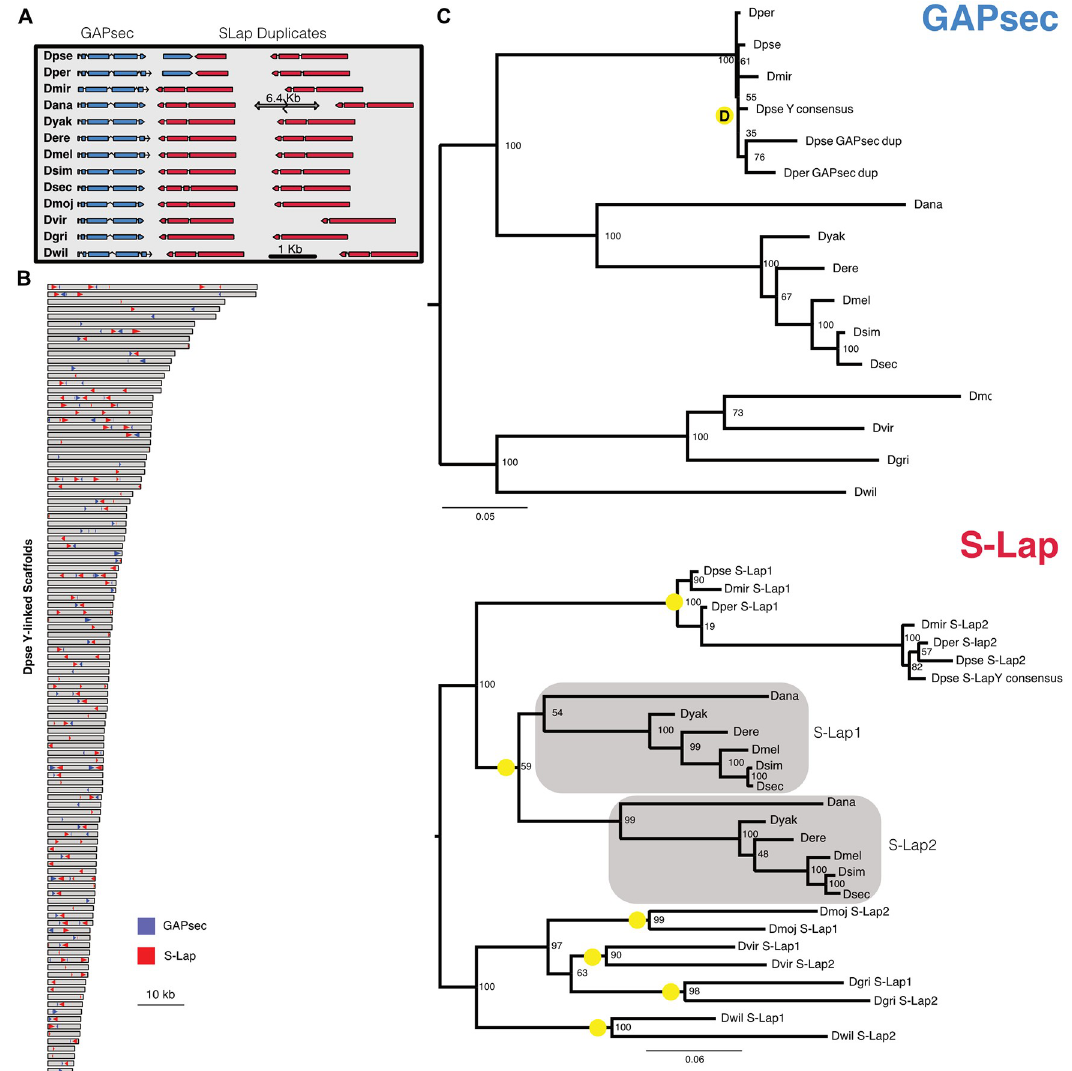
Fig 2. Molecular evolution of the S-Lap1 and GAPsec genes in Drosophila. A . Organization of S-Lap1 and GAPsec genes across the Drosophila genus. S-Lap1 (shown in red) is duplicated in all Drosophila species investigated, and GAPsec (shown in blue) shows a partial duplication in D . pseudoobscura and its sister species D . persimilis . B . Amplification of S-Lap1 and GAPsec on Y-linked scaffolds of D . pseudoobscura . Each rectangle represents a Y-linked genomic scaffold whose size is proportional to the scaffold length. The location and orientation of S-Lap1 (red) and GAPsec (blue) duplicates on each scaffold is represented by the colored arrowheads. C . Gene trees of S-Lap1 and GAPsec copies. A RAxML maximum likelihood phylogeny was inferred from alignments of the GAPsec and S-Lap transcripts for 12 Drosophila species plus D . miranda . The conserved genomic location of S-Lap1 and S-Lap2 across Drosophila suggests that they duplicated in an ancestor of Drosophila, and that gene conversion (indicated by the yellow circles) homogenized these tandem duplicates at different branches along the phylogeny. An inferred duplication event of GAPsec is shown by the yellow circle with a D. Alignments used to generate the trees shown in Fig 1C are provided as S1 and S2 Data. (S8 Table). CAGE-seq data support that the GAPsec duplicate generated a new TSS resulting in antisense transcription of S-Lap1 duplicate (Fig 4A).